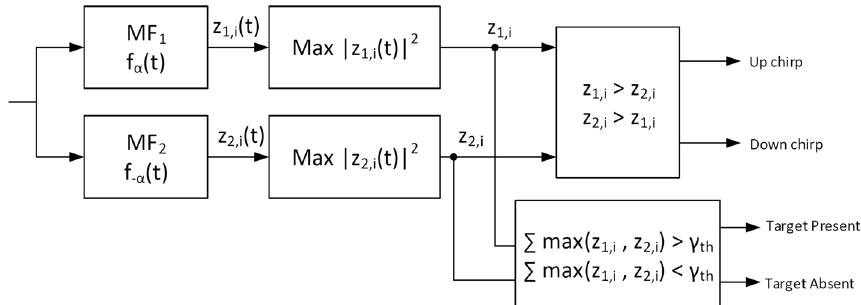
Fig. 2 Information decoding and detection using waveform